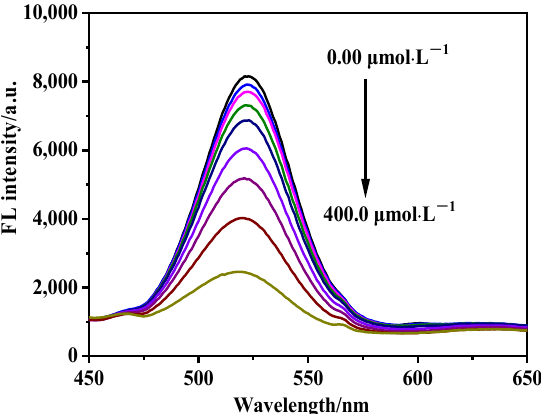
Figure 8. Fluorescence spectra of the MIP@SiO 2 @QDs with different concentrations of CAP.